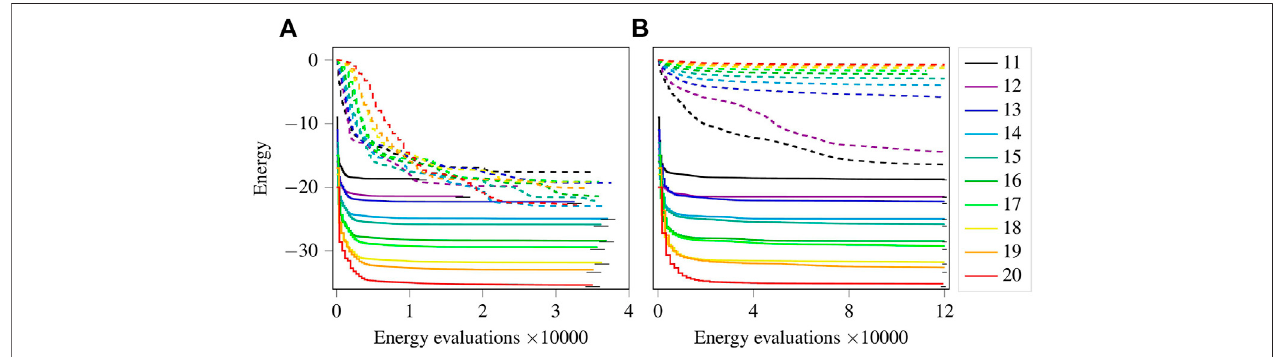
FIGURE 4| (Colour online) (A) : Progress comparison when initializing with zeros (solid lines) versus random values (dashed lines) as parameters for the XY-ansatz. (B) : Same as (A) , except for using the ansatz given by Eq. 7 . Legend depicts the lattice size for both (A,B) . The small horizontal black lines represent the ground state